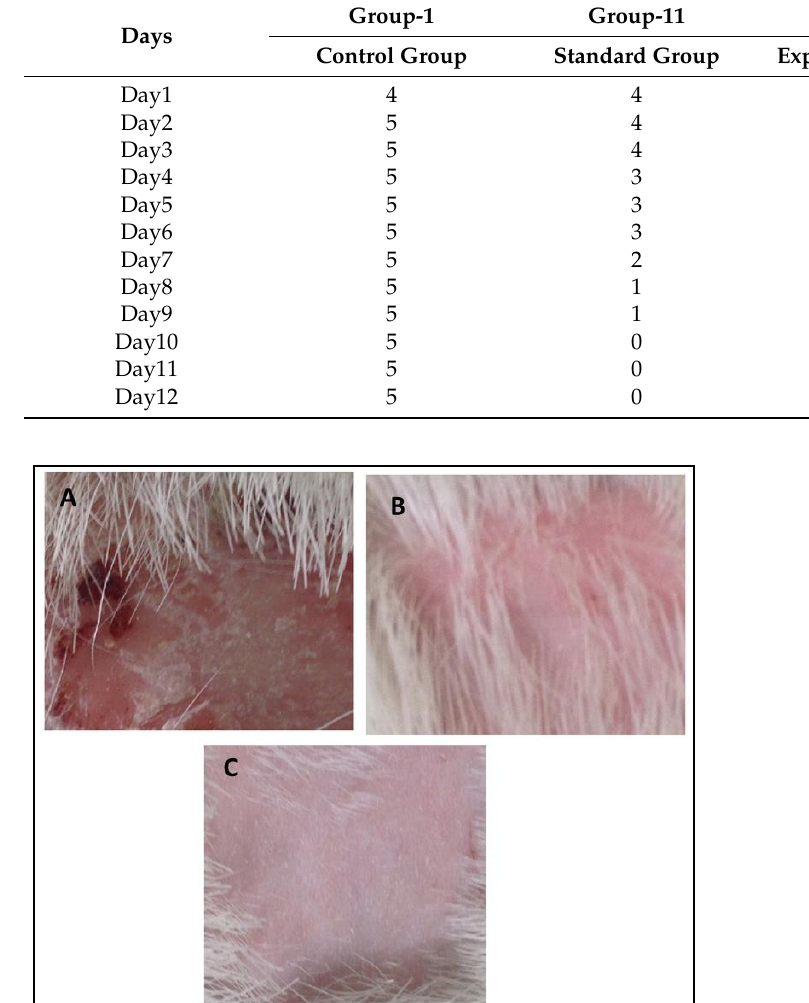
Figure 8. ( A ) Control group, ( B ) recovery from infection in the standard group, ( C ) recovery from infection in the experimental group.